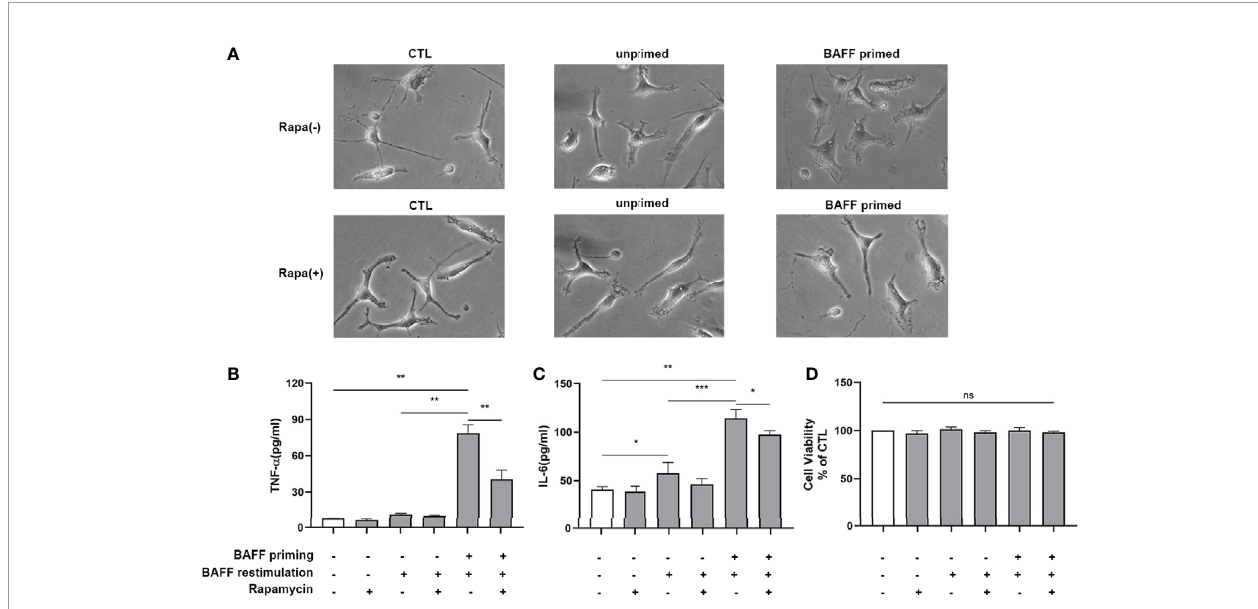
FIGURE 10 | Rapamycin suppressed proin fl ammatory memory-like state of primary microglial cells induced by BAFF training. Primary microglia were pretreated with 100 nM rapamycin for 1 h and then treated with BAFF (10 ng/ml) or vehicle for 24 h. On day 6, microglial cells were restimulated with BAFF (40 ng/ml) for 24 h. (A) The representative micrographs of primary microglial cells on day 7. The amounts of TNF- a (B) and IL-6 (C) were measured in the culture supernatants on day 7. (D) Cell viability of primary microglial cells on day 7 was tested by MTT assay. Data are mean ± SEM (n = 9); Kruskal-Wallis test with Turkey post hoc test; *p < 0.05, **p< 0.01, and ***p< 0.001, ns: no signi fi cance between